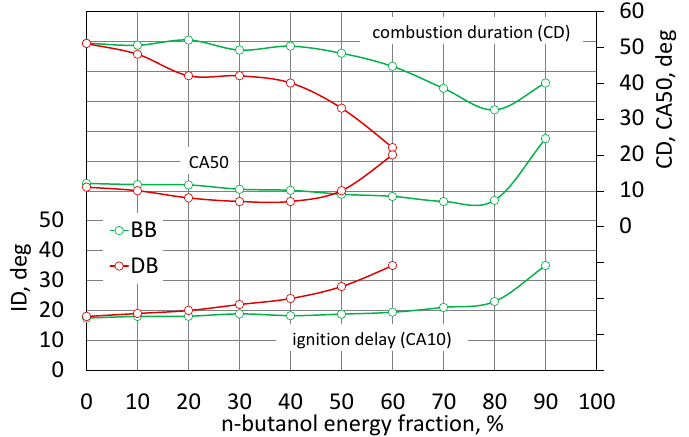
Figure 9. The stages of CA10, CA50 and CA90 combustion.